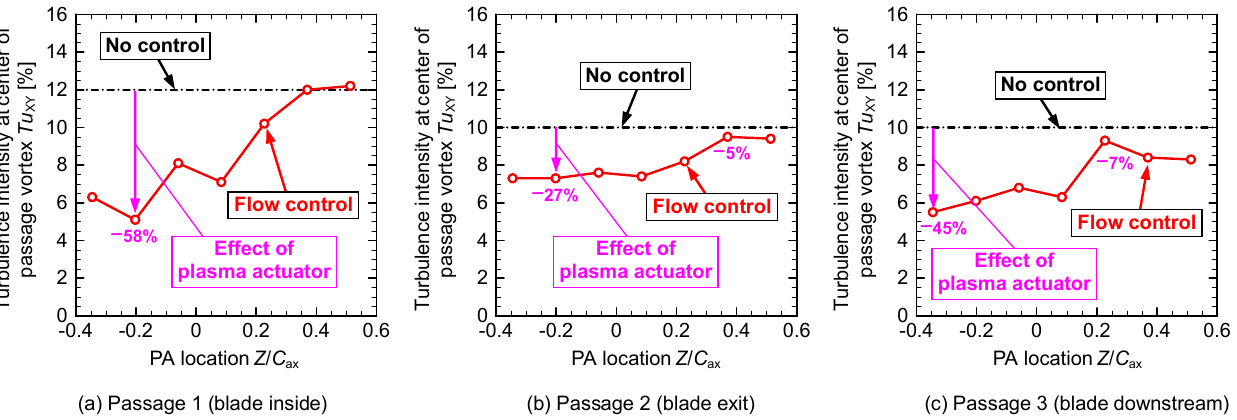
Figure 23. Effect of the plasma actuator location on the turbulence intensity at the center of the passage vortex (Re out = 3.7 × 10 4 ).